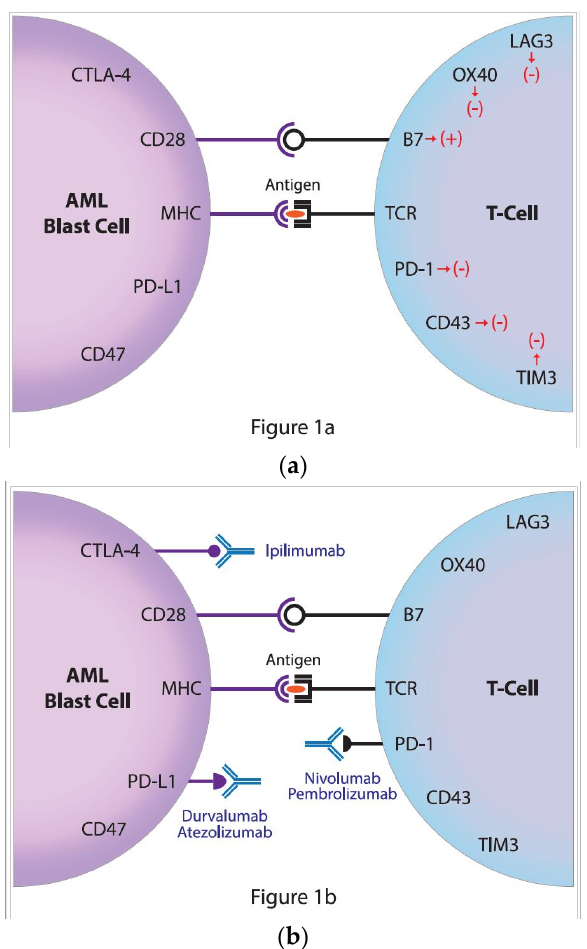
Figure 1. ( a ) The regulation of antileukemic immune response; the activation of an immune response requires two signals. The first is responsible for the specific recognition of antigen (peptide) located in the great groove of the major histocompatibility complex (MHC) by the T-cell receptor (TCR). The second is the costimulatory signal that is transmitted by the interaction of CD28 and B7 molecules. These signals are regulated by many negative receptors including the lymphocyte-activation gene 3 (LAG3), OX40, programmed cell death protein 1 receptor (PD-1), CD43 as well as T-cell immunoglobulin domain and mucin domain 3 (TIM3) on the T cell that interacts with ligands on acute myeloid leukemia (AML) blasts, i.e., CD47, programmed death-ligand 1 (PD-L1) and Cytotoxic T-lymphocyte Antigen-4 ( CTLA - 4 ). ( b ) The restoration of antileukemic immune response by the targeting of the negative control checkpoints. In order to restore the antileukemic immune response, two inhibitory immune checkpoint molecules might be targeted by treatment with specific monoclonal antibodies directed against the cytotoxic T-lymphocyte antigen-4 (CTLA-4), ipilimumab, and the programmed cell death protein